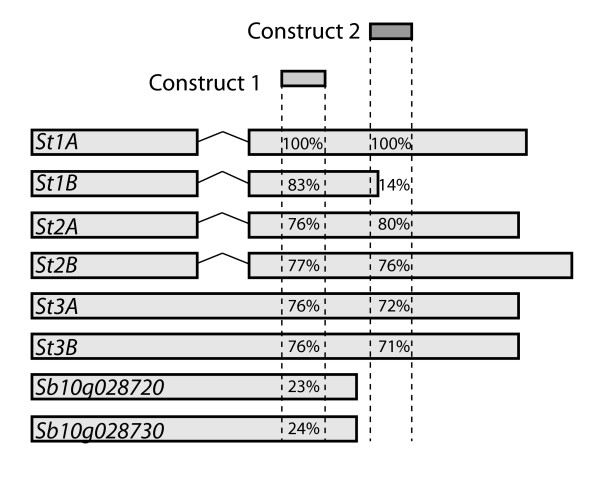
Schematic alignment of VIGS constructs and St genes and their closest off-target genes. Two sections of St1A were PCR amplified and ligated into VIGS plasmid pF13m. The identity of the constructs to each of the St genes is shown. E values for construct 1 and 2 against St and closest off target genes; St1A 2e-128, 2e-128; St 1B 4e-68, NA; St2A 2e-34 5e-48; St2B 1e-43 6e-60; St3A 2e-33 8e-27; St3B 3e-32 4e-24; Sb10g028730 3e-07, NA; Sb10g028720 3e-06, NA. NA indicates no significant similarity.